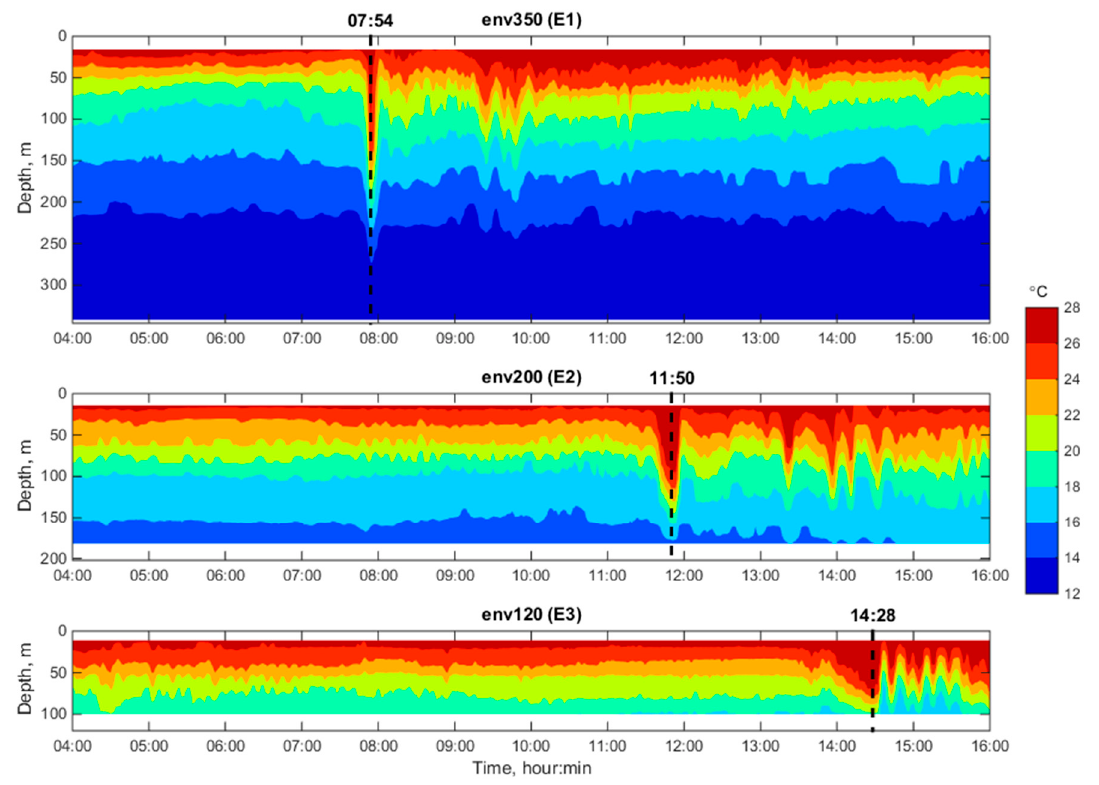
Figure 4. Temperature versus time for three thermistor strings (May 7, 2001). The dotted lines show the arrival times of the soliton under consideration.